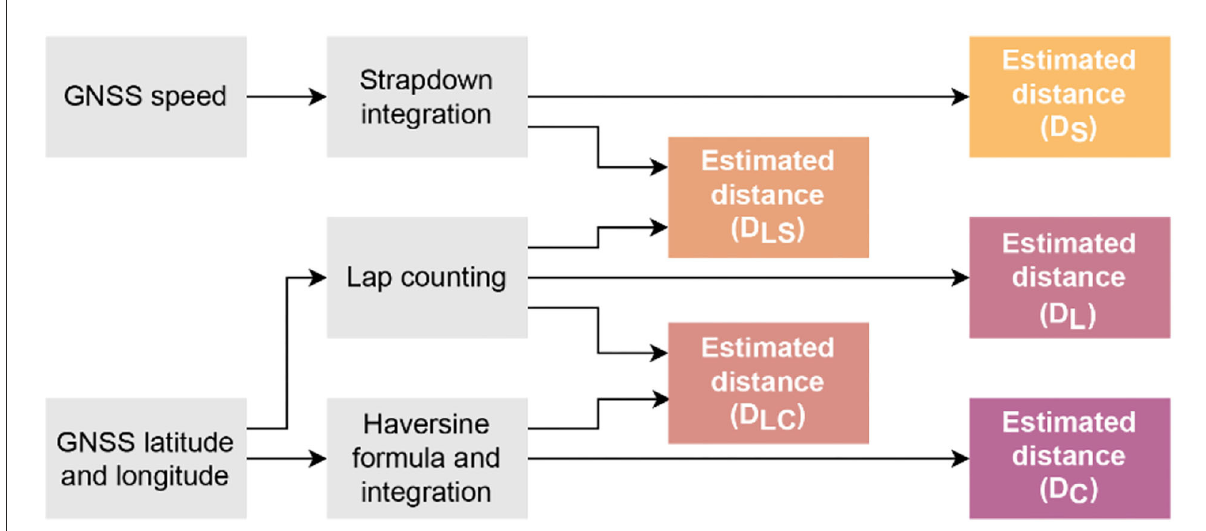
FIGURE4 Different methods for the estimation of distance covered over the 12-min